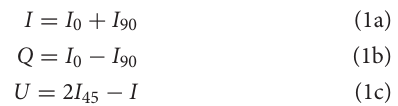
FIGURE 1 | (A) The measuring view, i.e., the view of the cave opening as seen from the inner balcony. (B) A map of Rosh HaNikra grottoes, which shows the geographical set-up of the cave opening and inner balcony, and land-ocean boundaries at sea level (adapted from Sela,